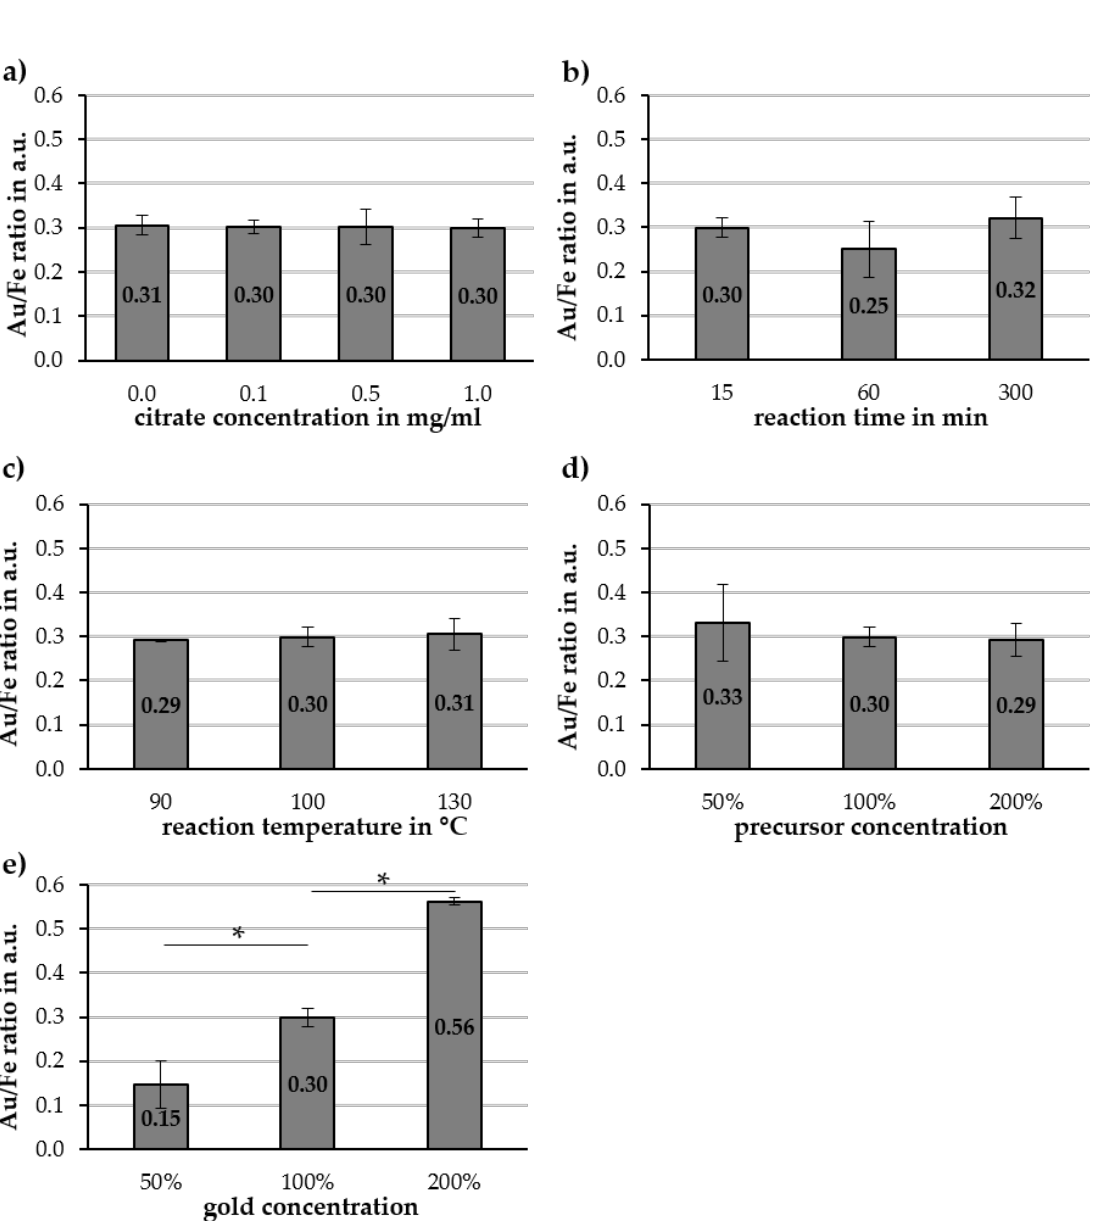
Figure A6. Gold to iron ratios of synthesized Cit-Au-SPIONs with varied ( a ) citrate concentration in the particle dispersion, ( b ) reaction times, ( c ) reaction temperatures, ( d ) precursor concentrations and ( e ) gold concentrations. The targeted Au / Fe ratio for ( a – d ) was 0.30. For ( e ) the targeted ratios were 0.15, 0.30 and 0.60 for 50%, 100% and 200%, respectively. Statistically significant changes are marked with * for p < 0.05.